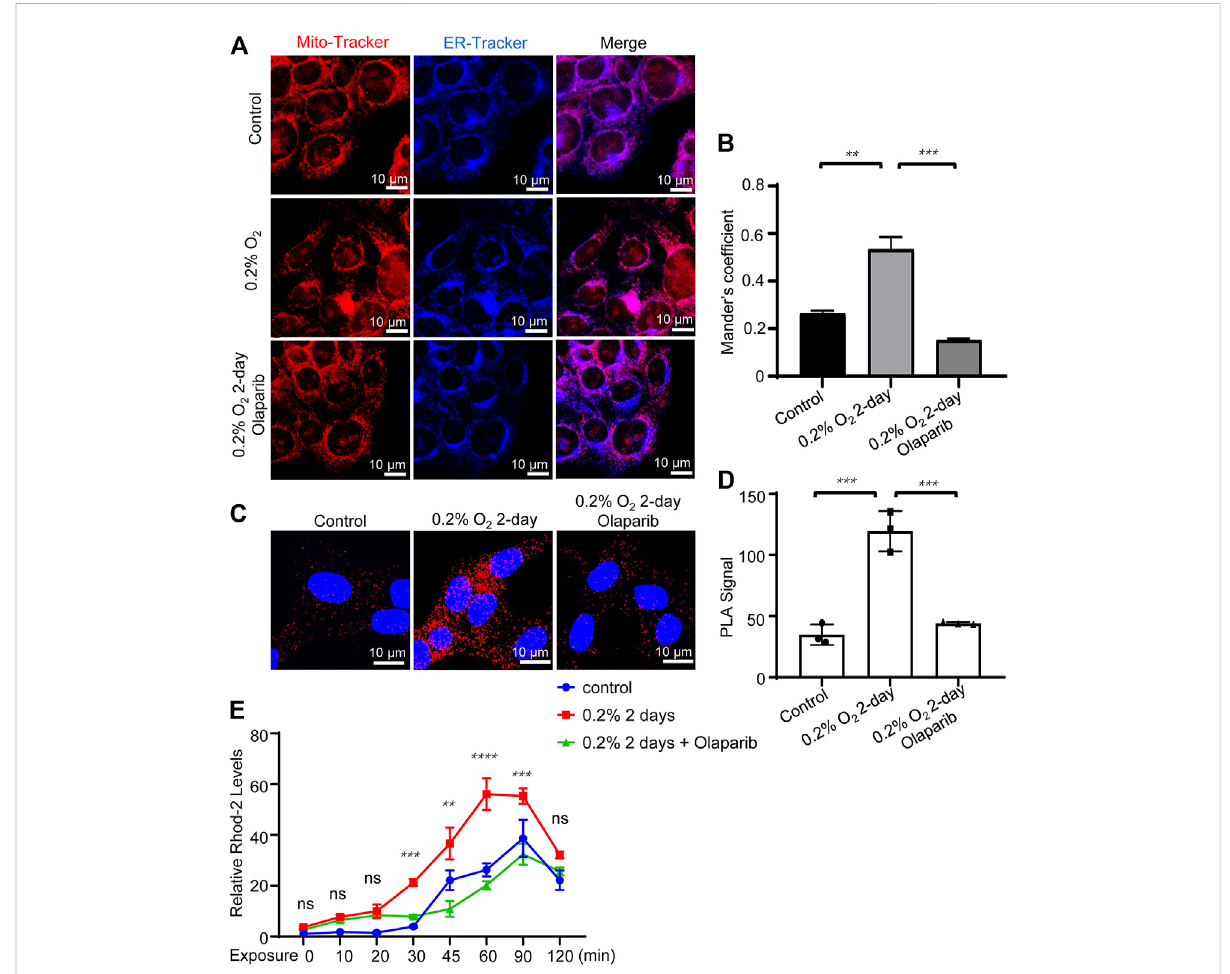
FIGURE 8 Olaparib alleviates hypoxic stimulation-induced MAMs dysregulation. (A) Representative Mito-Tracker and ER-Tracker co-staining fl uorescent images for the control, 0.2% O 2 , and 0.2% O 2 + olaparib groups. Scale bar, 10 μ m. (B) Colocalization analyses were calculated as Mander ’ s colocalization coef fi cients (MCC) using the ImageJsoftware. (C) PLA signals showed that hypoxia (0.2% O 2 )increased MAMs signaling, as evidenced by the increased VDAC1/ITPR3 interactions in R28 cells. PLA signals also showed that olaparib (100 nM) relieved PLA signals under hypoxic stress. Scale bars, 10 μ m. (D) PLA signals were analyzed using the ImageJ software. (E) Rhod-2 staining showed that olaparib relieved hypoxia- induced Ca 2+ in fl ux. The p -values were determined using one-way or two-way ANOVA with Tukey ’ s test for multiple comparisons. pp p < 0.01, ppp p < 0.001, and pppp p <